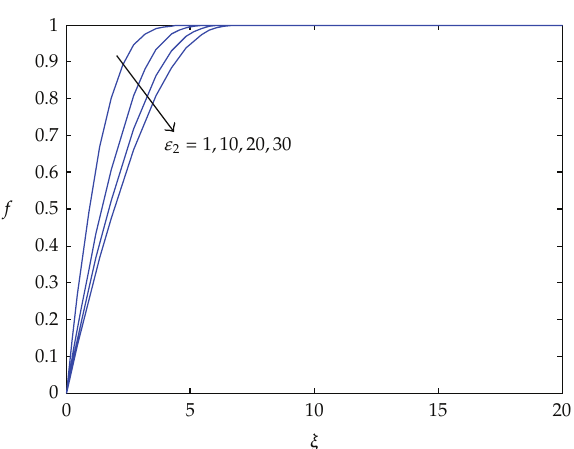
Figure 3: E ff ect of ε 2 parameter on the similarity function f related to the x component of velocity (cid:7) ε 1 (cid:5) 1, n (cid:5) 2 (cid:8) .